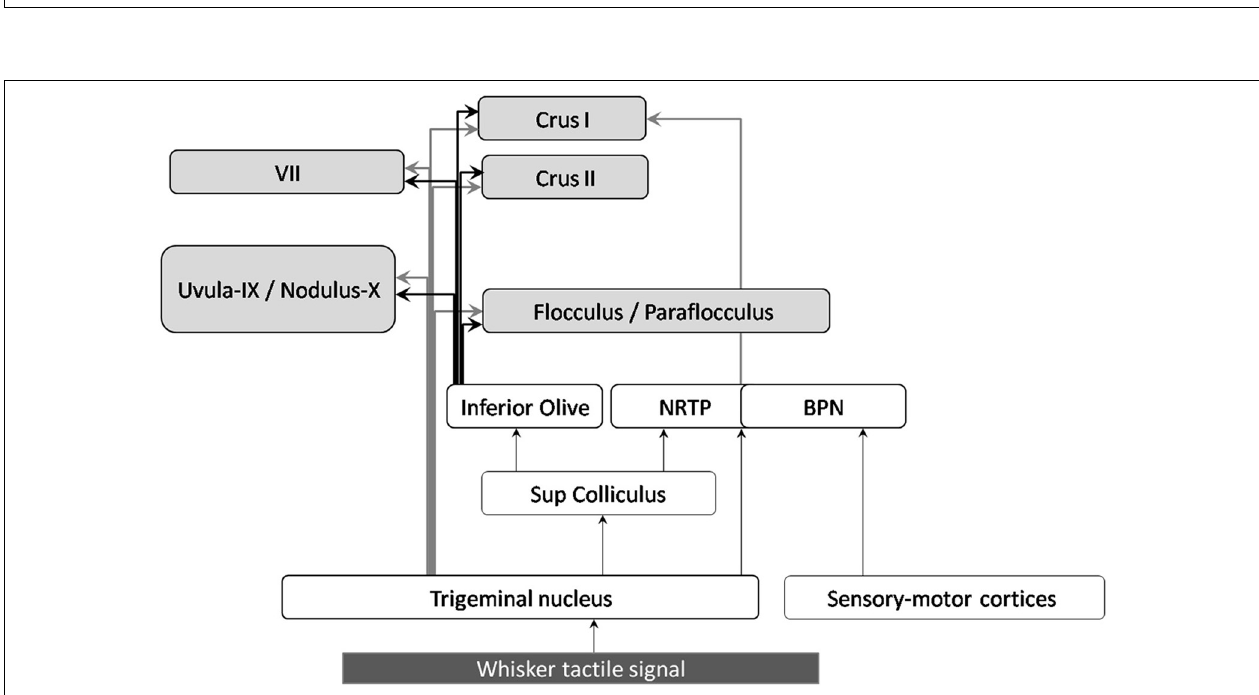
NOT, Nucleus of the Optic Tract; BPN, Basilar Pontine Nuclei; NRTP, Nucleus Reticularis Tegmenti pontis; PrH, Prepositus Hypoglossi Nucleus. Note that the vermal regions of the cerebellar cortex (lobule VII, Uvula-Nodulus) are represented on the left whereas the hemispheric regions are represented on the right (Crus I, II, flocculus-paraflocculus).